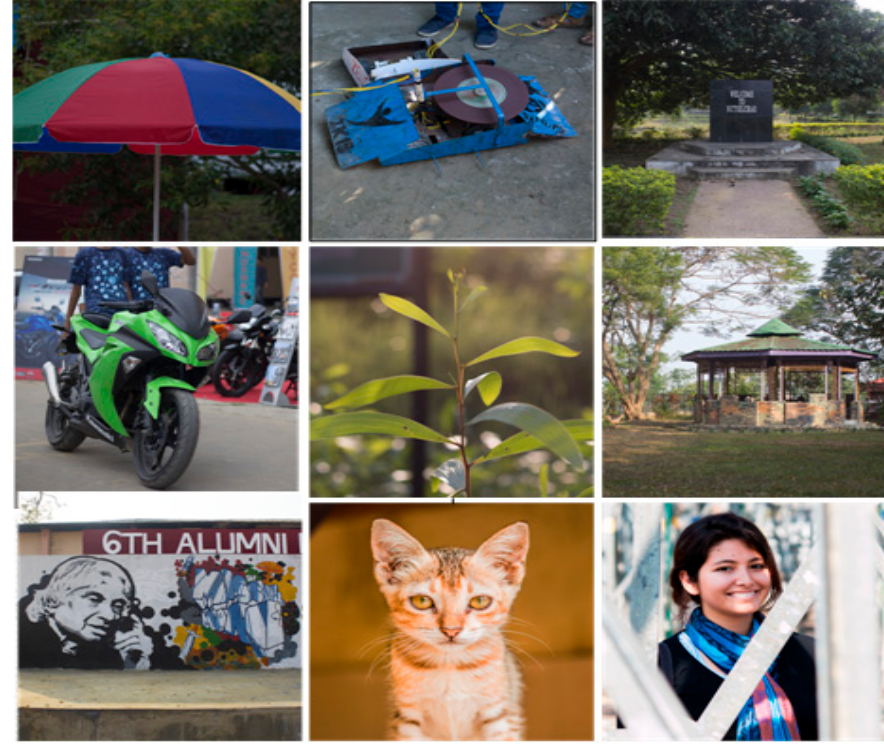
Figure 2. Original images from NITS-IQA database.